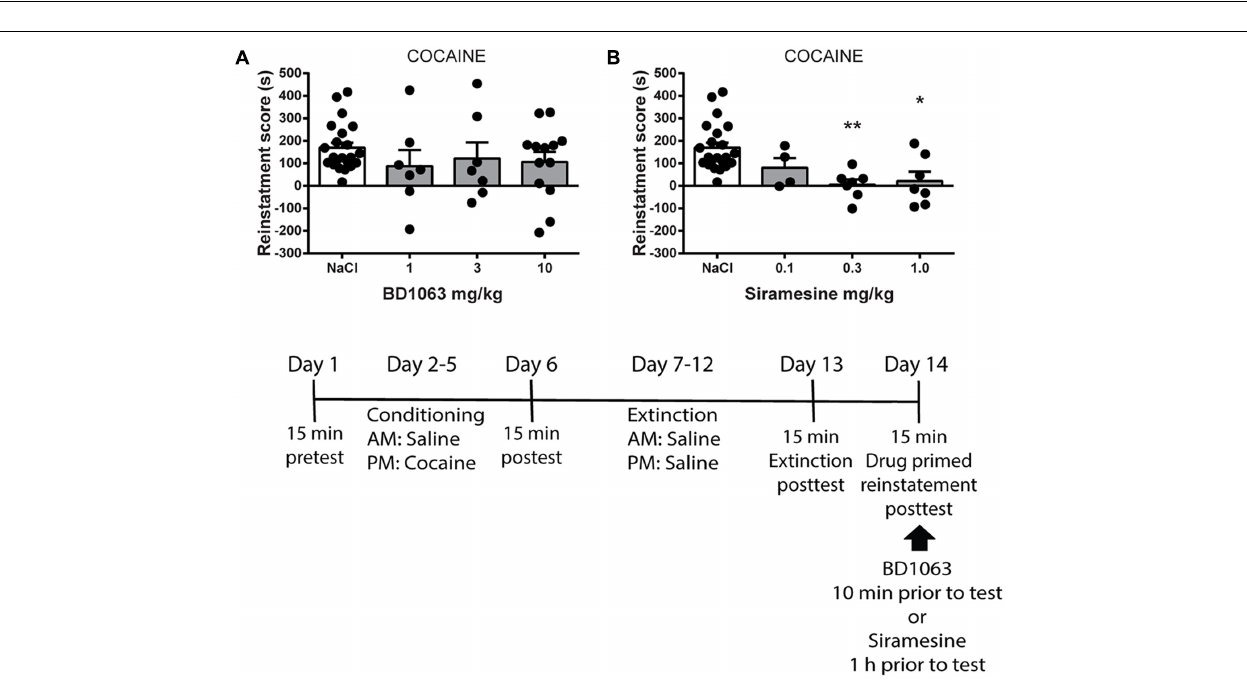
FIGURE 4 | Drug-primed reinstatement of cocaine-place preference. (A) BD 1063 does not prevent drug-primed reinstatement ( n = 22, 7, 7, and 13) as shown by mean ± SEM. In contrast, (B) Siramesine blocks cocaine-primed reinstatement of a previously extinguished place preference ( n = 22, 4, 7, and 7). CPP scores from NaCl-treated control mice were pooled and represented in both graphs. ∗ p < 0.05, ∗∗ p < 0.01. One-way ANOVA followed by Dunnett’s post hoc